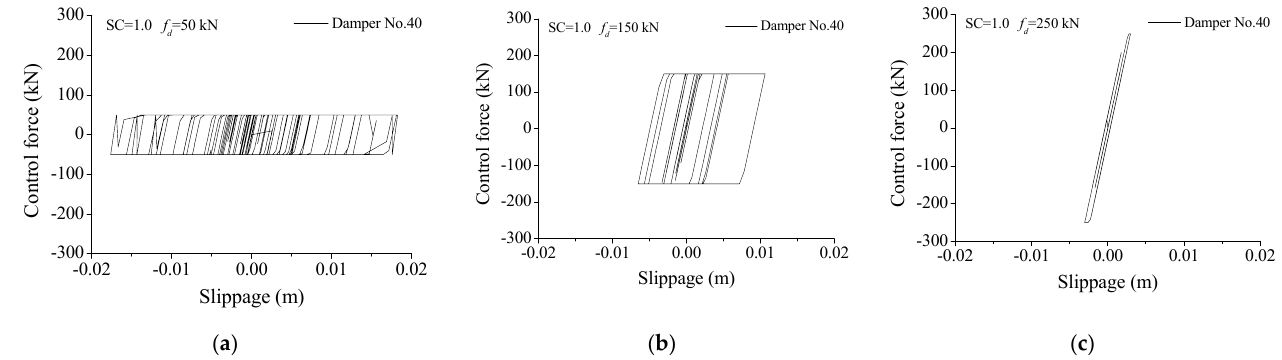
Figure 15. Hysteresis loops of friction dampers under different damper forces. ( a ) fd = 50 kN; ( b ) fd = 150 kN; ( c ) fd = 250 kN.